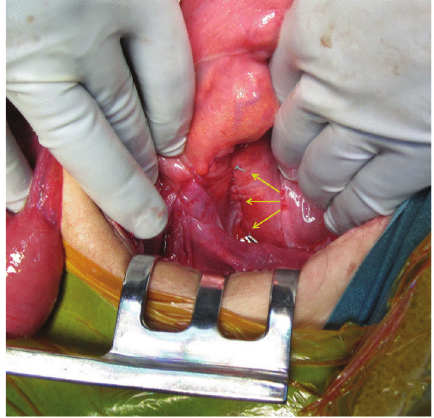
Figure 4: Pouchopexy by suturing the pouch to the presacral fascia on either side of the mesentery of the pouch